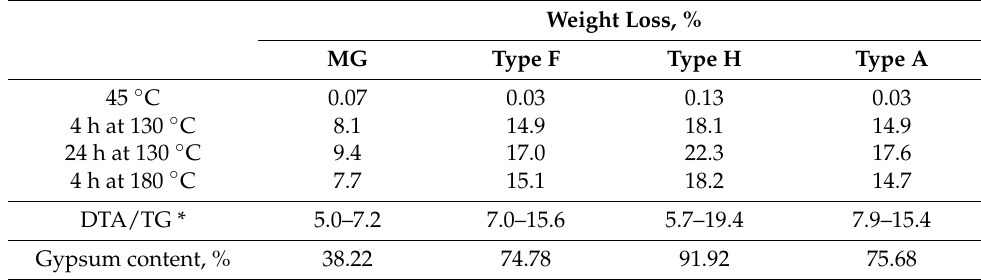
Table 3. Weight loss after heating and calculated gypsum